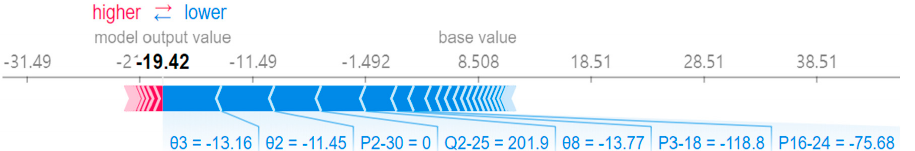
Figure 9. ( a ) SHAP dependence of P 37 ; ( b ) SHAP dependence of P 38 . The red square means the risk of transient instability is high when the value of P37 or P38 is 0. 5. Conclusions An automated ML scheme (AutoML) was proposed to realize power system online TSA. Under this framework, auto-feature selection and Bayesian optimization were re- spectively introduced to automatically determine the crucial input features and optimal hyperparameters of the CatBoost-based TSA learning model. Multiple evaluation indices were considered to improve the performance of Bayesian optimization. By leveraging these techniques, faster deployment of the ML-based TSA could be achieved, and the de- pendence on human expertise is significantly reduced. To help operators understand why a stable/unstable status prediction is made, inter- pretability analysis was embedded into both offline and online stages of the AutoML